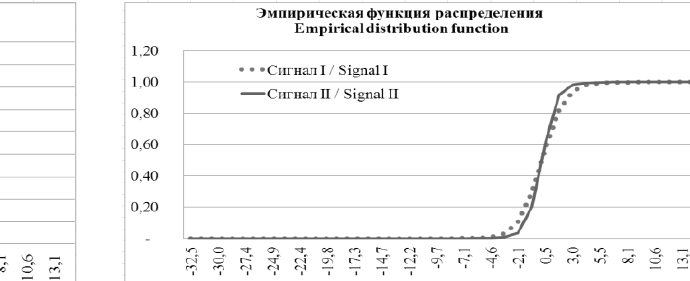
Fig. 11. The histogram of relative frequencies for a signal I and a signal II.